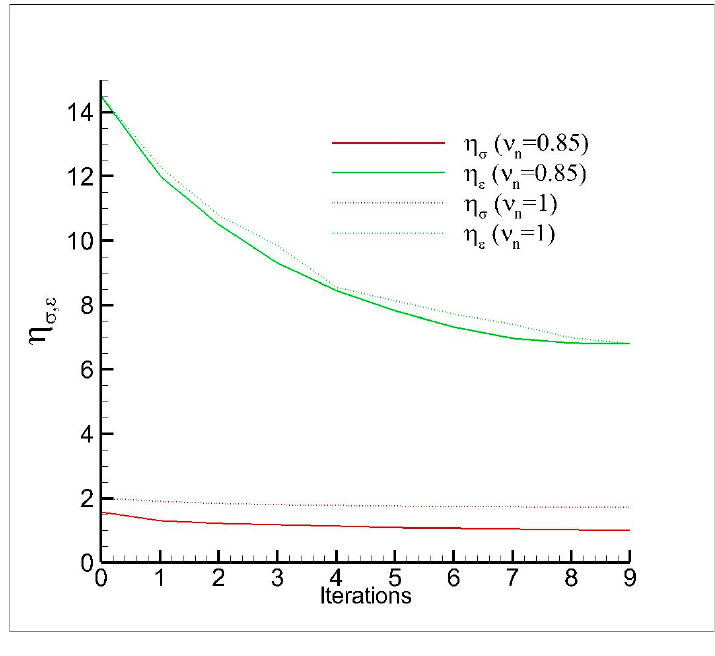
Figure 12. Global / Local performance with respect to the reference Model—comparison between Figure 12. Global/Local performance with respect to the reference Model—comparison between di ff erent levels of non–conformal meshes—Local Model 1. different levels of non–conformal meshes—Local Model 1.